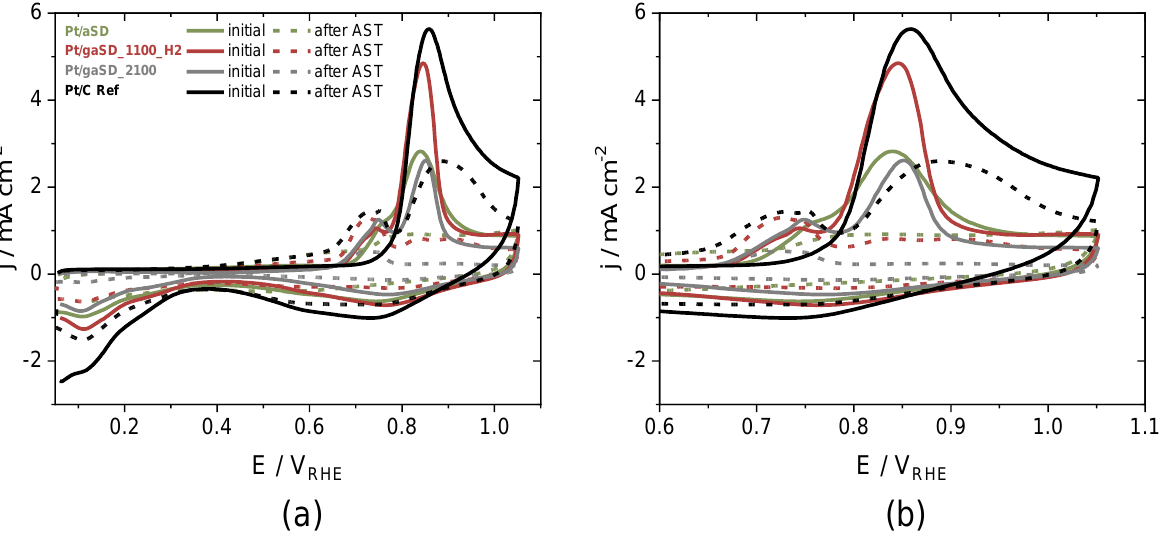
Figure 8. ( a ) Electrochemical CO stripping profile and ( b ) zoom of catalysts Pt/aSD, Pt/gaSD_1100_H2, Pt/gaSD_2100 and Pt/C ref before (initial) and after the AST (0.6 – 1.5 V RHE , 5000 cycles) in CO − saturated electrolyte. Catalyst loading was 40 µg Pt cm −2 . After performing the AST, all samples reveal overall lower currents in the CO oxidation profiles. While Pt/gaSD_1100_H2 and Pt/C ref show the evolution of a dominant peak at lower potentials (Figure 8b), the overall CVs of Pt/aSD and Pt/gaSD_2100 basically show a flat shape without any distinct peaks. This matches the determined losses in ECSA HUPD where largely decreased values were observed for those two catalysts. For Pt/gaSD_1100_H2 it can be stated that the majority of the active Pt nanoparticles show a high ratio of rather agglomerated particles as the peak around 0.8 V RHE almost totally diminishes. In case of Pt/C ref the dominating peak at higher potentials decreases and the peak at lower potentials arises, suggesting that the reduced ECSA HUPD after AST is at least partially caused by Pt particle